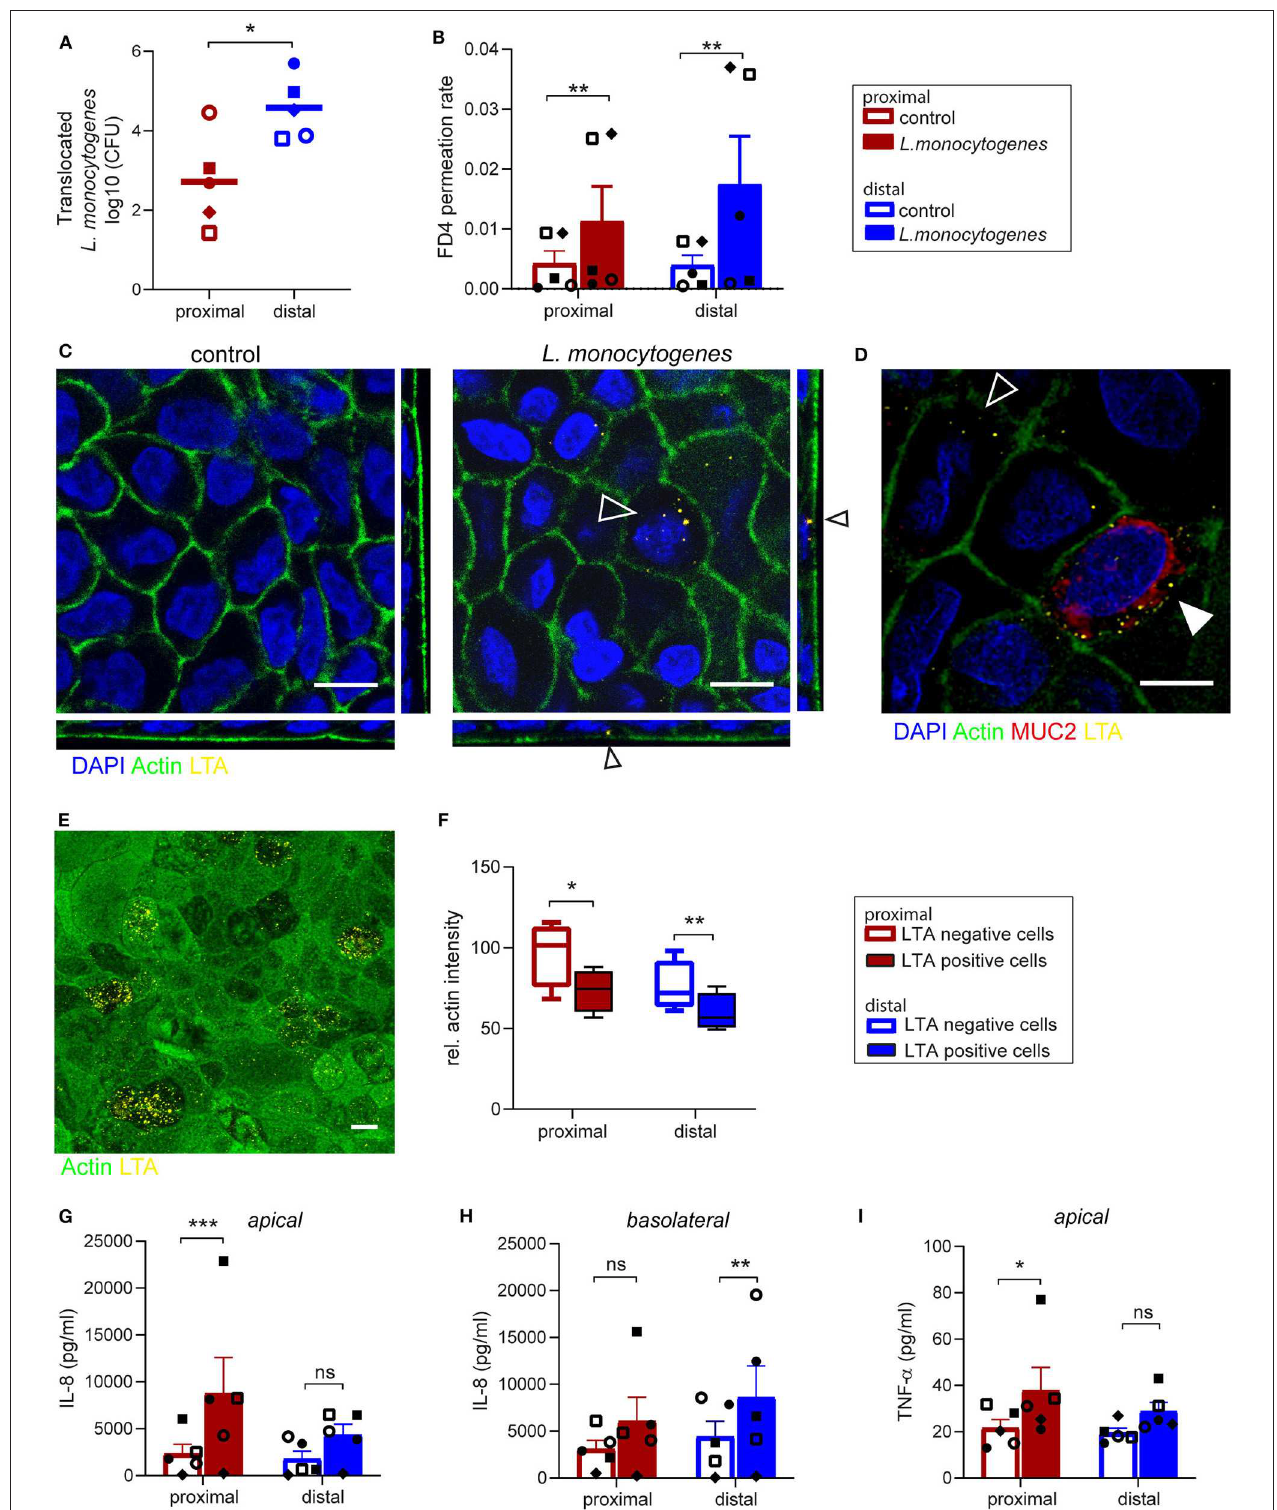
FIGURE 4 | Listeria monocytogenes can invade and translocate across proximal and distal small intestinal epithelium. (A) Listeria monocytogenes translocation across proximal and distal small intestine epithelium 5h post-infection determined by CFU detected in basolateral medium. (B) FD4 permeation rate from apical to basolateral compartment in control and infected monolayer cultures at 5h post-infection. (C) Representative image of L. monocytogenes infected (open arrow) and